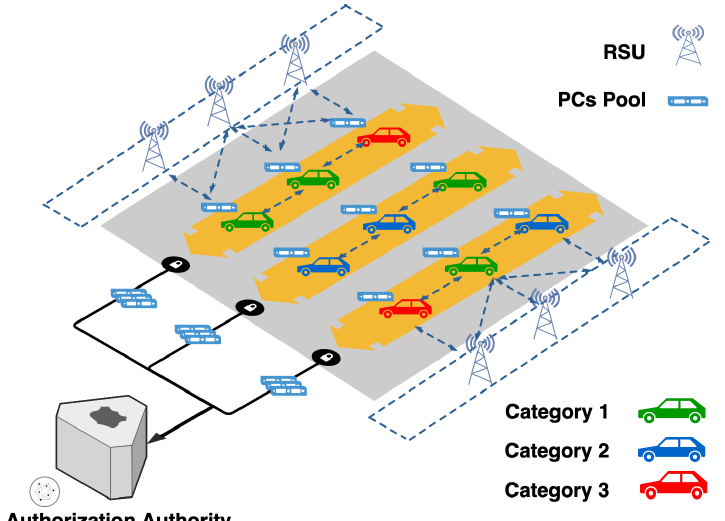
Figure 5. The authorization authority adapts the pseudonym pools sent to each privacy